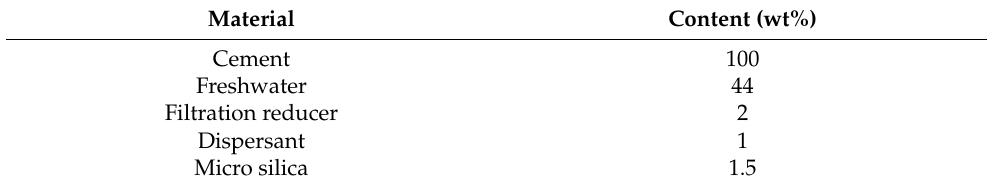
Table 2. Cement paste components.